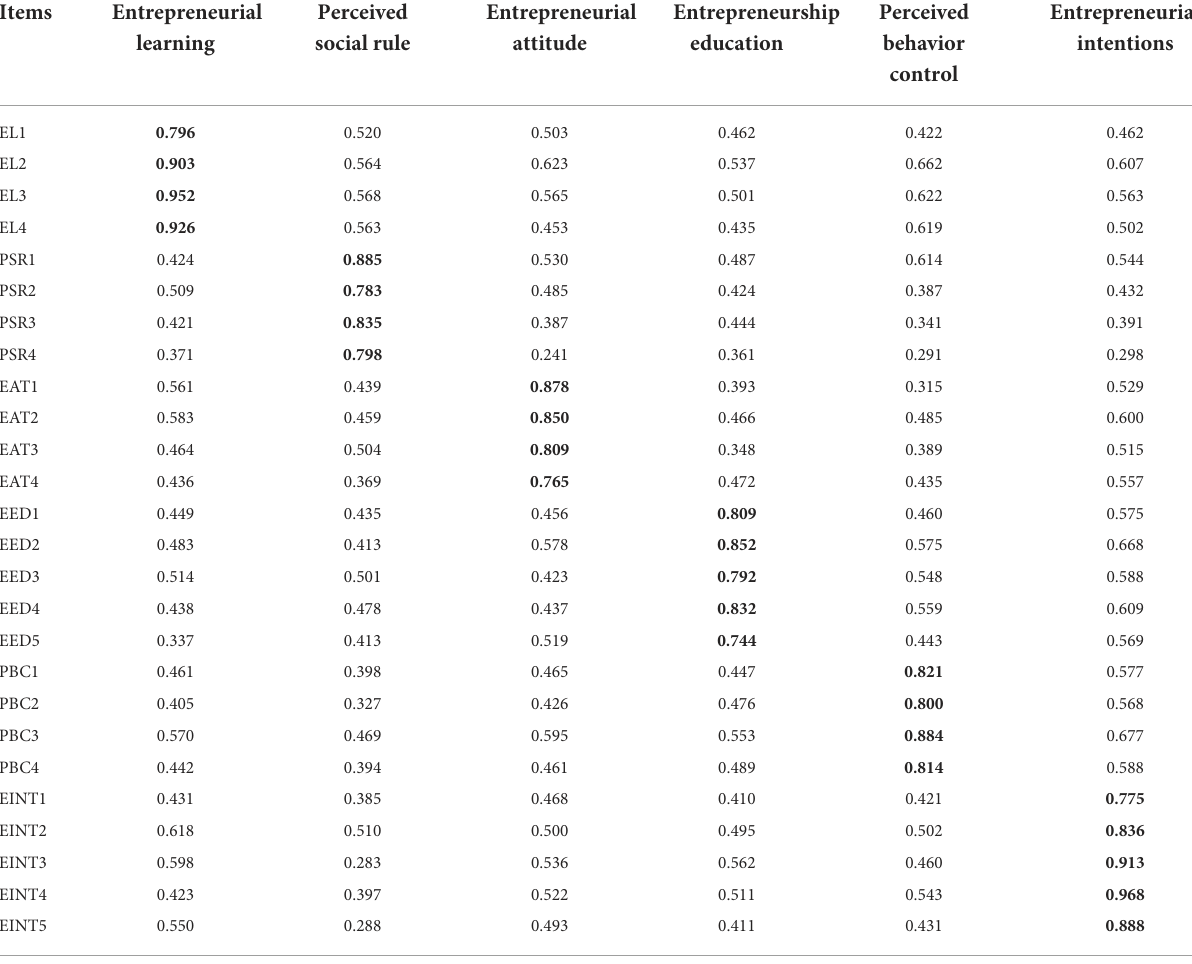
TABLE 4 Discriminate validity–loading and cross-loading criterion.